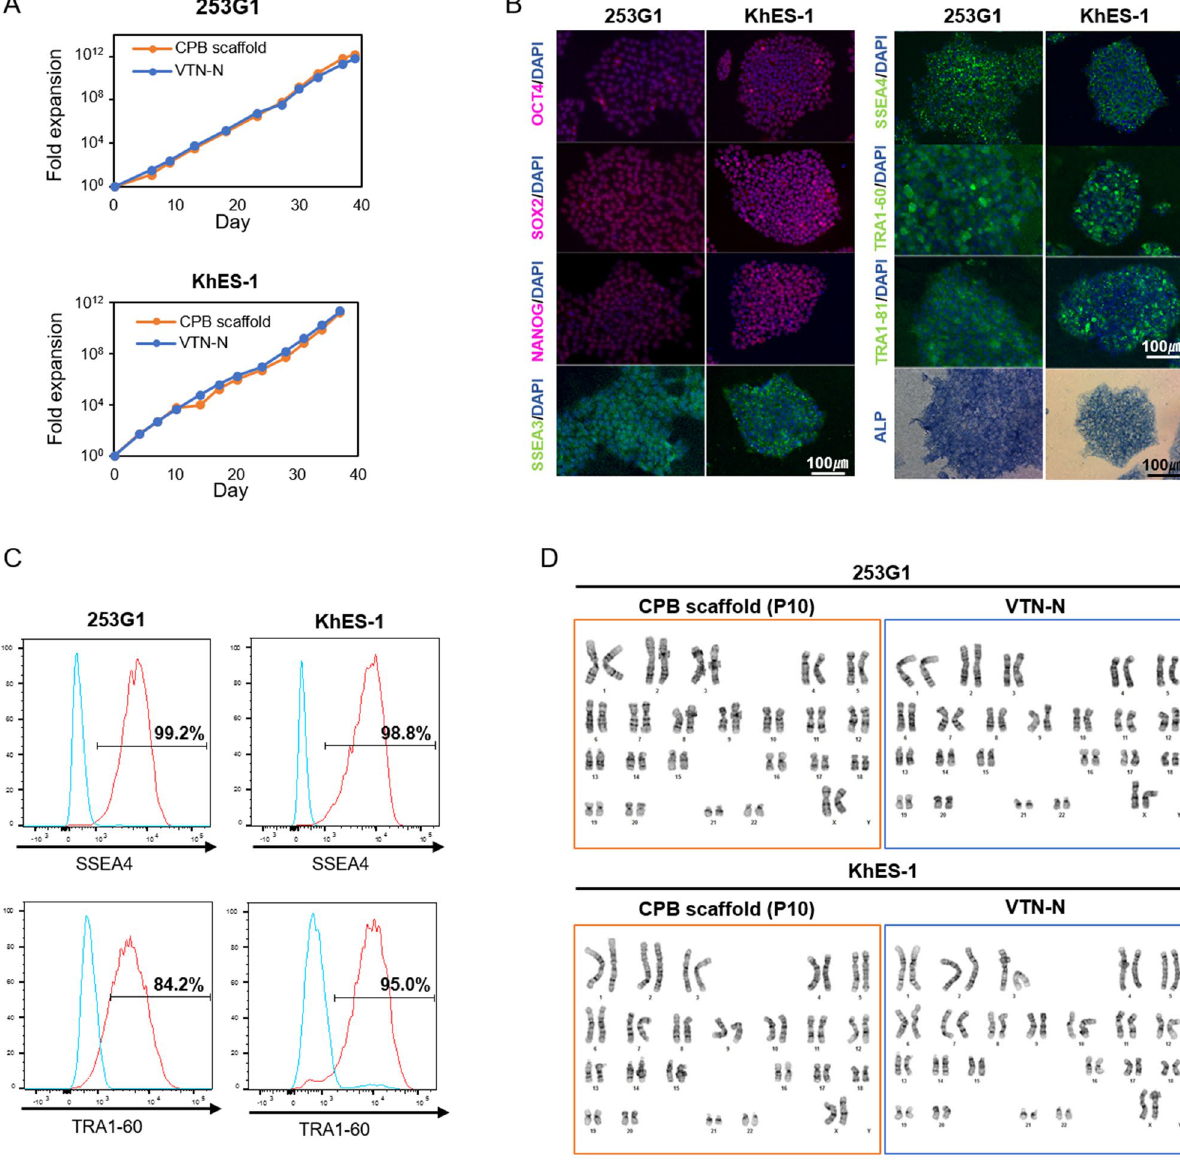
Figure 6. Characterization of human induced pluripotent stem cells and human embryonic stem cells after long-term culture on CPB scaffold. ( A ) Comparison of fold expansion rates of the 253G1 and KhES-1 cell lines on CPB scaffold or VTN-N in Essential 8 medium. Fold expansion is shown in a one-logarithmic graph, and cell passages were performed more than 10 times. The orange circle on the graph shows the number of cells of 253G1 or KhES-1 cultured on CPB scaffold, and the blue circle shows the number of cells cultured on VTN-N. ( B ) Pluripotency marker immunostaining and alkaline phosphatase (ALP) expression analysis. Pluripotency markers are red or green. Nuclear staining is performed with DAPI and shown in blue. ALP is blue in bright field. The scale bar represents 100 µm. ( C ) FACS analysis of pluripotency marker-positive 253G1 and KhES-1 cells. Red and blue histograms show the stained and unstained control populations, respectively. At least 10,000 cells were measured for each sample. The vertical axis shows the mode standardized to 100. The percentage of marker-positive cells is indicated on each graph. ( D ) G-band karyotyping of the cells maintained on CPB scaffold or VTN-N. Using 253G1 cells or KhES-1 cells passaged 10 times or more on CPB scaffold or VTN-N, we observed normal chromosome numbers in 50 cells and performed karyotyping of 20 of them. A typical chromosomal image is